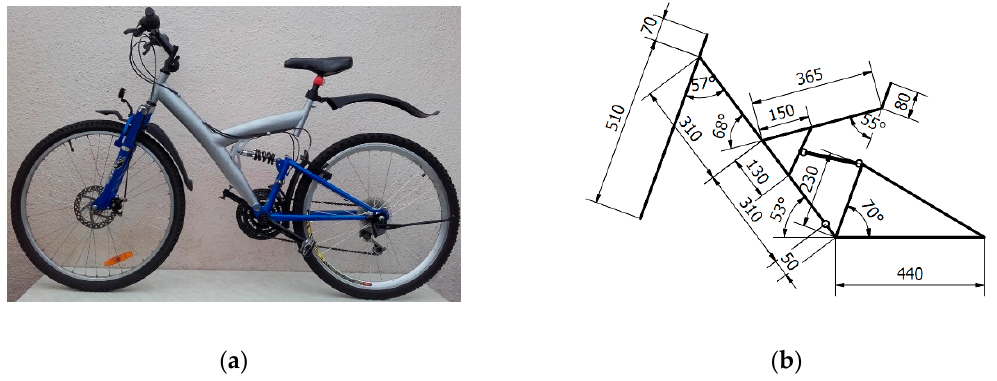
Figure 9. Numerical example 2—mechanical system: ( a ) photograph; ( b ) CAD model (reprinted from